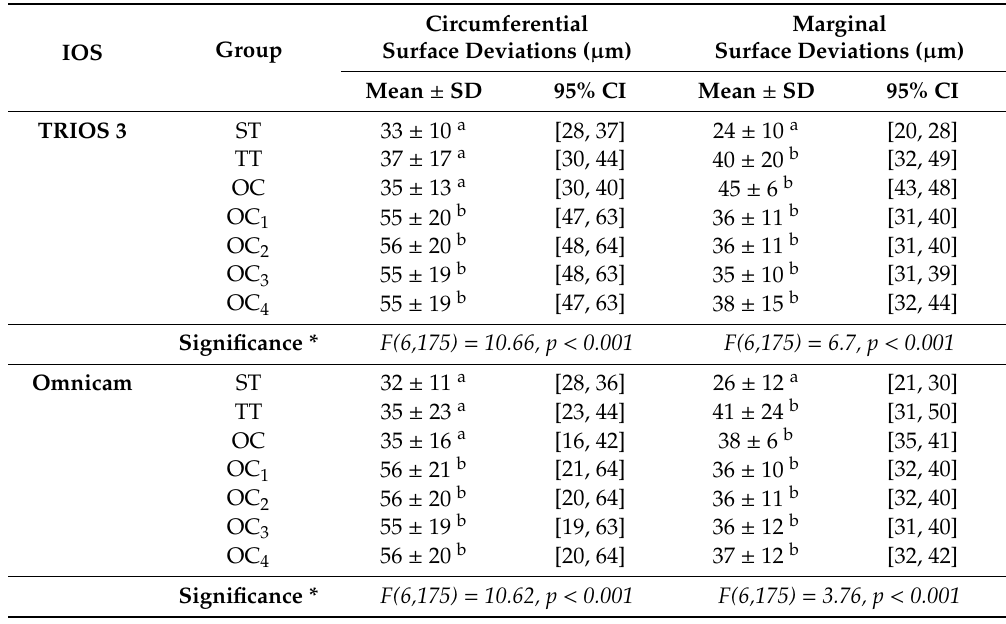
Table 1. Mean, standard deviation (SD), and confidence intervals (CIs) of the circumferential and marginal surface deviations. For each group n =